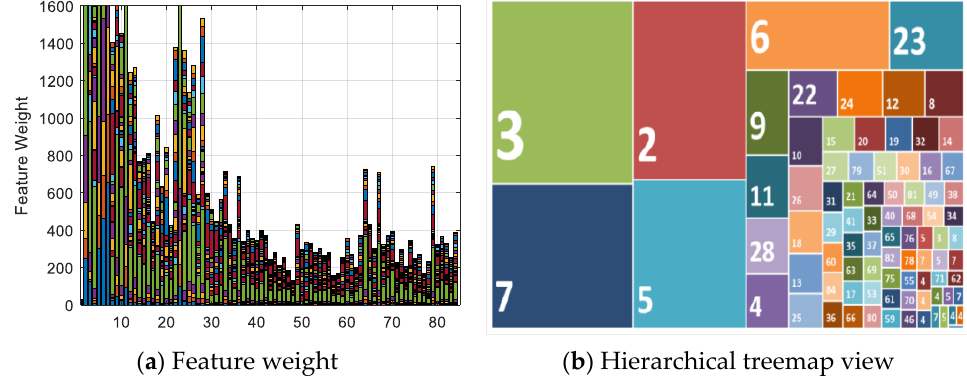
Figure 4. Relationship of the feature numbers with the spectral and color performance.